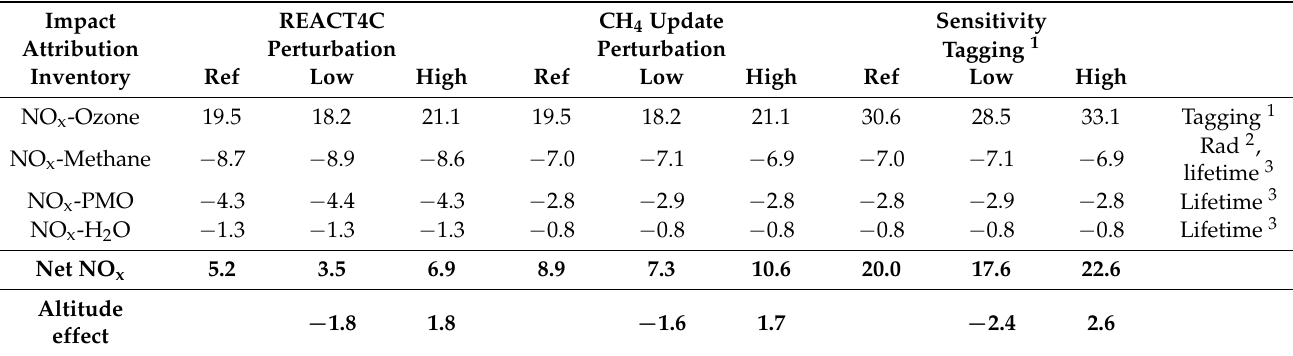
Table A1. Radiative forcing [mW/m 2 ] of individual aviation-induced nitrogen oxide effects based on REACT4C results ([14]), perturbation approach and updating estimates, following [16]. Absolute forcings and change of radiative forcing due to alternative flight altitudes.